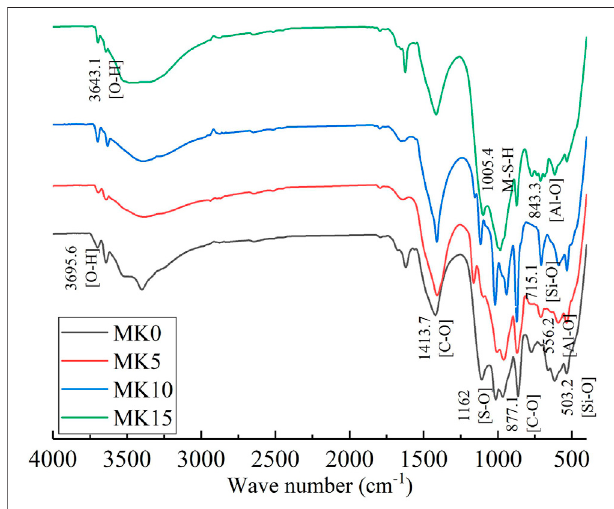
FIGURE 4 | FTIR diagram of concrete with different metakaolin